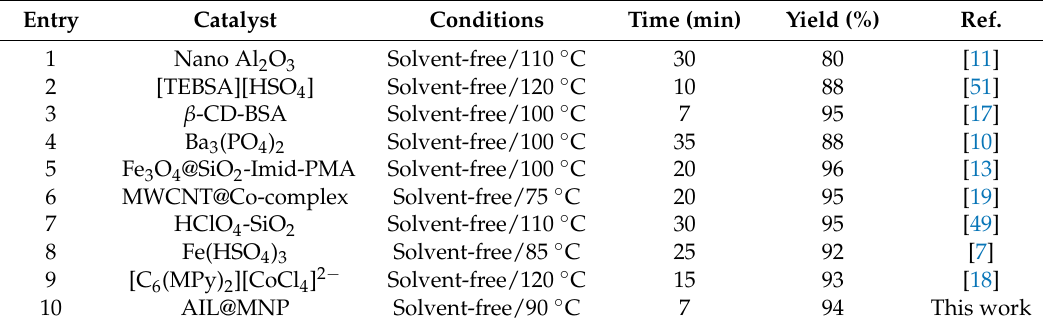
Table 3. Comparison of different catalysts for the one ‐ pot three ‐ component reaction of 4 ‐ nitrobenzaldehyde, 2 ‐ naphthol and acetamide.